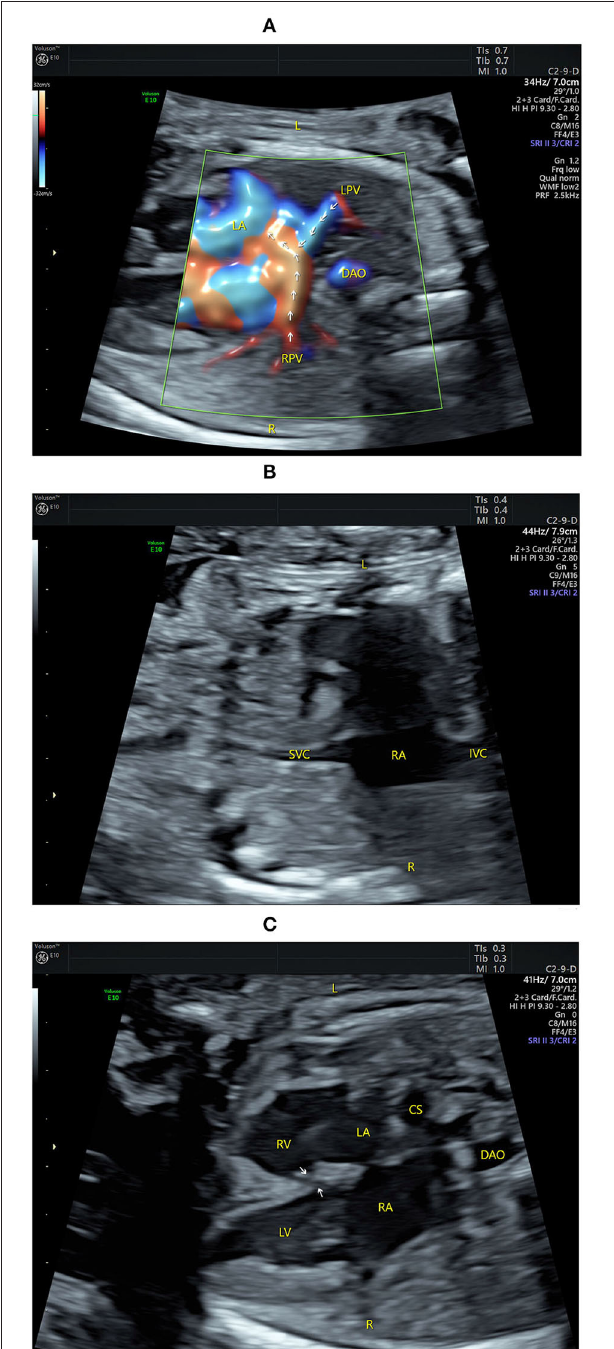
FIGURE 1 | Echocardiograms showing fetal atrial situs and the four-chamber view (4CV). (A) The pulmonary veins drain into the left atrium (indicated by arrows) on the left of the fetus by high-definition flow imaging (HDFI). (B) The superior vena cava and the inferior vena cava are connected to the right atrium on the right of the fetus. (C) The 4CV shows a heart of normal size with balanced chambers, situs solitus of the atria, atrioventricular discordance, a VSD (indicated by arrows), and an enlarged coronary sinus. CS, coronary sinus; DAO, descending aorta; IVC, inferior vena cava; L, left; LA, left atrium; LPV, left pulmonary vein; LV, left ventricle; R, right; RA, right atrium; RPV, right pulmonary vein; RV, right ventricle; SVC, superior vena